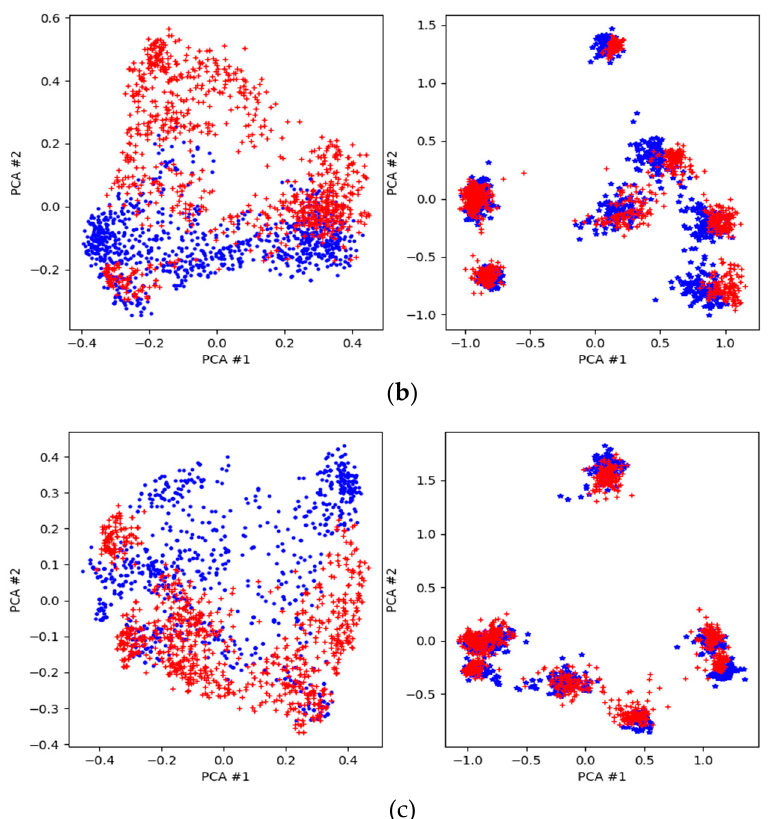
Figure 8. PCA for the transfers: ( a ) Potsdam → Vaihingen; ( b ) Trento → Toronto; ( c ) Toronto → Vaihingen. First column: before adaptation; second column: after adaptation.